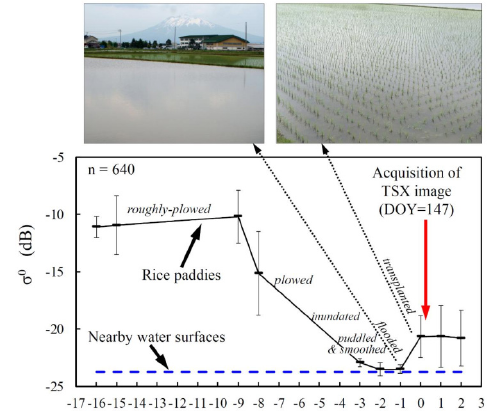
Fig.5: Sentinel-1 acquisition covers the seasonal rice